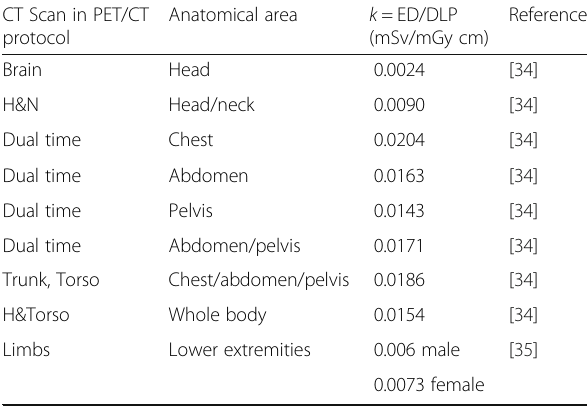
Table 1 Dose conversion factors from DLP to ED CT Scan in PET/CT protocol